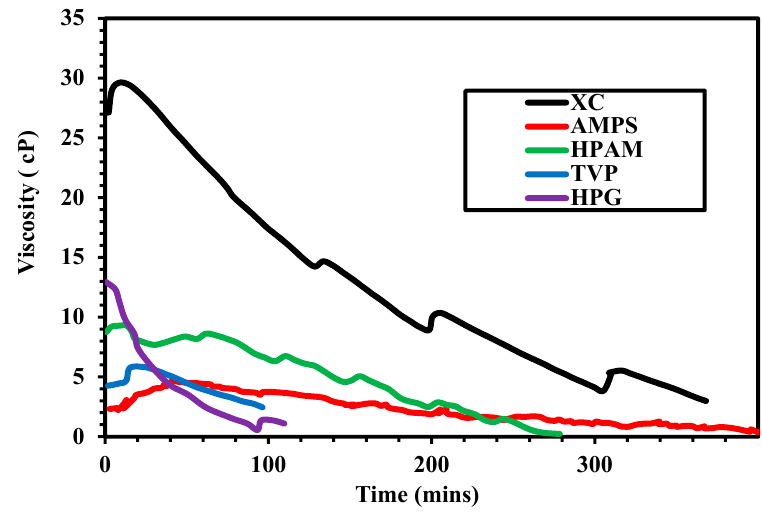
Figure 5. Apparent viscosity of different polymers (20 pptg) with glutamic acid diacetic acid (GLDA) (20 wt %) in deionized water (Shear rate = 511 s − 1 , T = 300 °F, P = 300 psi, pH = 12).